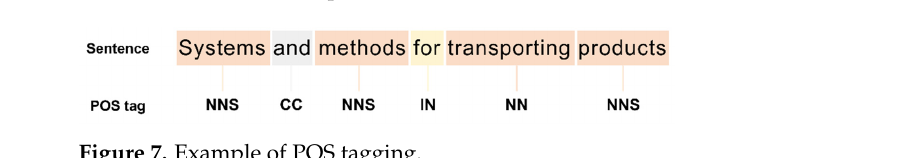
Figure 7. Example of POS tagging.